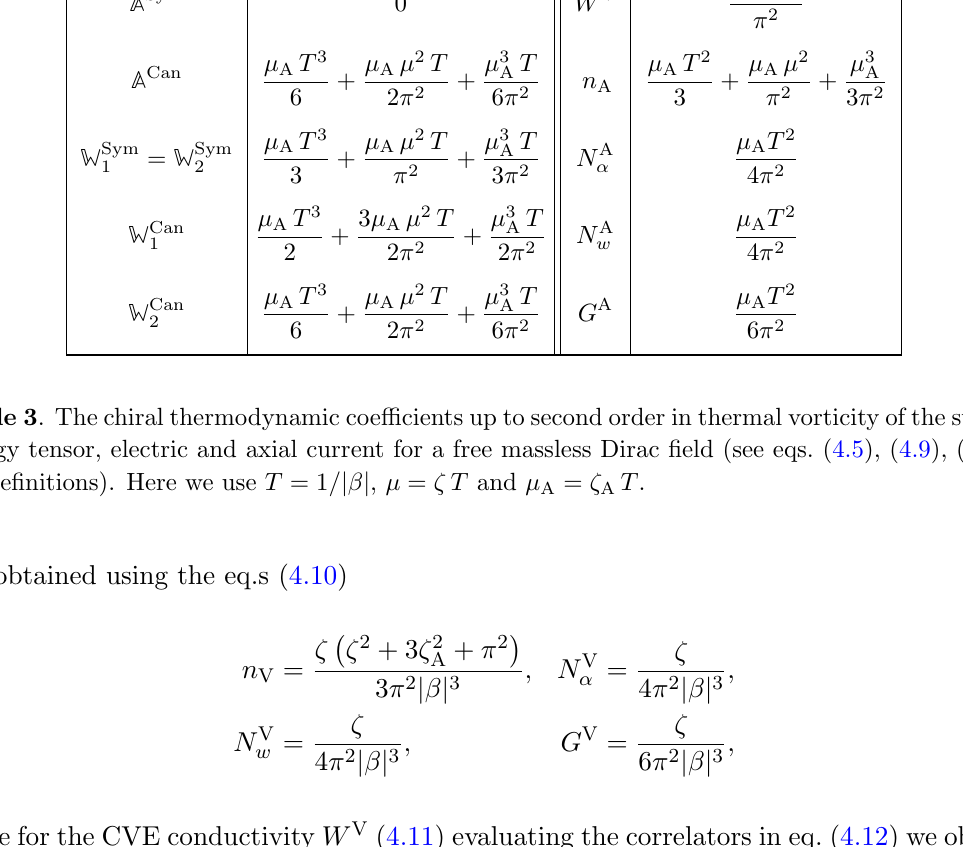
while for the CVE conductivity W V (4.11) evaluating the correlators in eq. (4.12) we